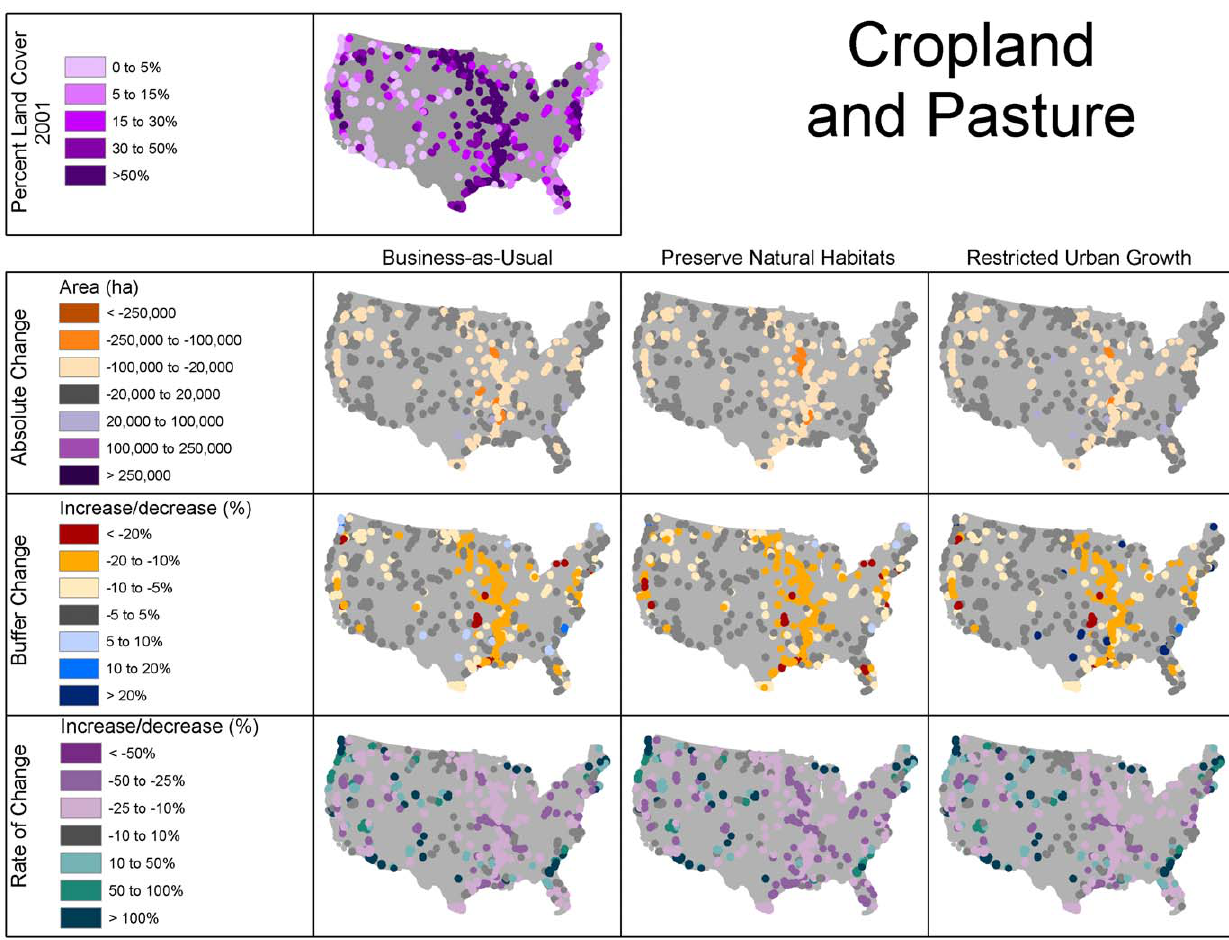
Figure 4. Initial land use and change in crop/pasture land use under the different scenarios.